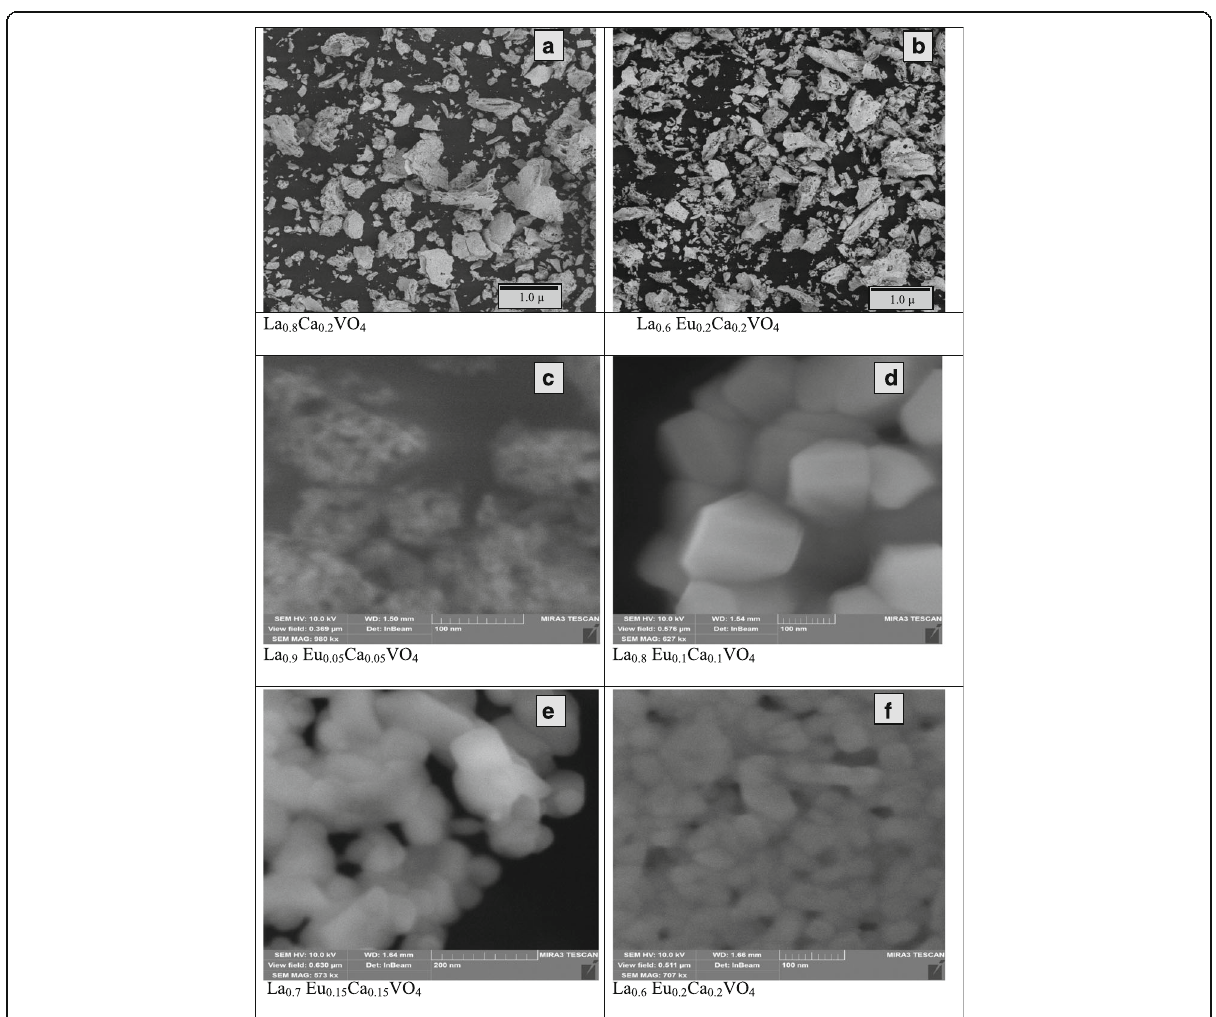
Eu0.15Ca0.15VO4 ( e ) samples